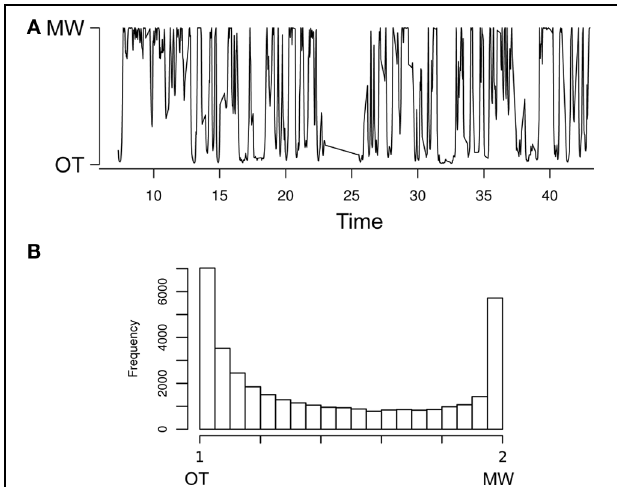
FIGURE 6 | (A) Posterior distribution of hidden state across the experimental session of an arbitrary participant (time in minutes). (B) Posterior distribution of the hidden states across all participants and trials. This distribution seems bimodal, meaning that the model categorically distinguishes between the two hidden